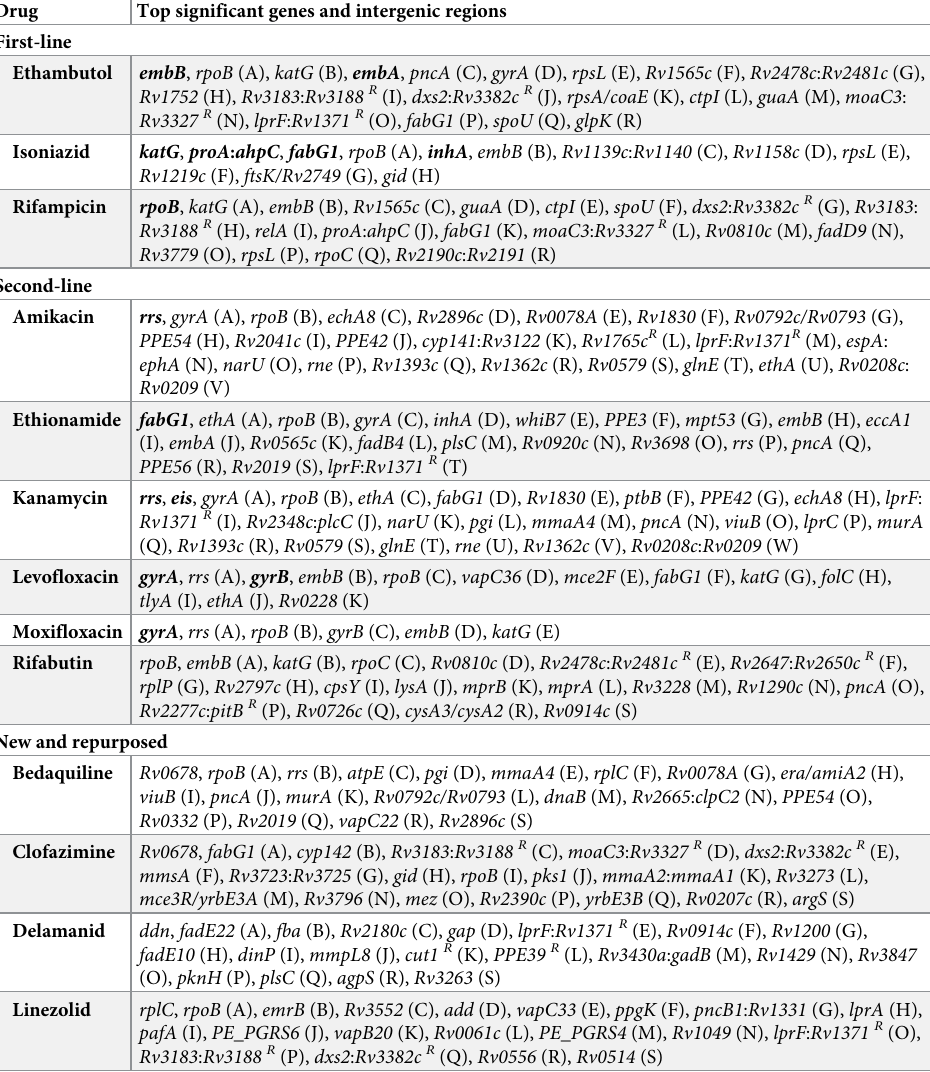
Table 1. The top genes or intergenic regions ranked by their most significant oligopeptides per drug, up to a max- imum of 20 (more only when the 20th was tied). Genes are highlighted in bold if they were catalogued for that drug by [11,17].Gene names separated by colons indicate intergenic regions. Genes or intergenic regions capturing repeat regions are highlighted with the superscript R . Alphabetic characters following gene names are used to cross-reference with the corresponding Manhattan plots in Fig